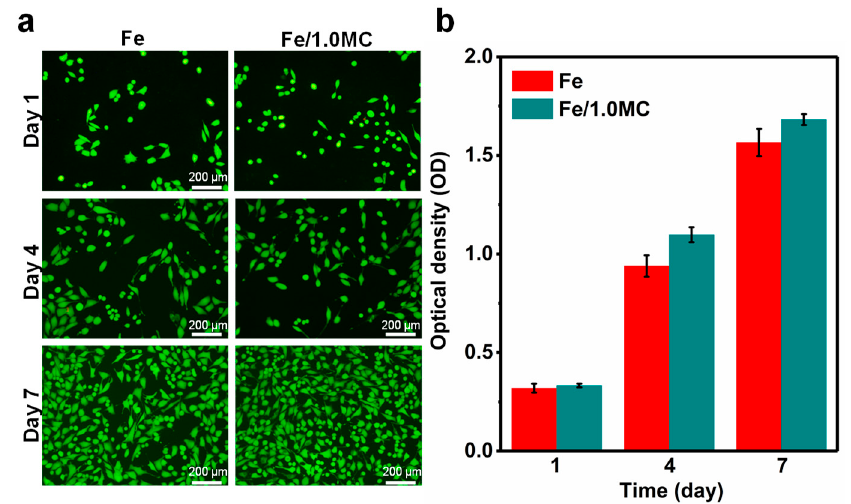
Figure 9. ( a ) Fluorescent microscopy images of stained cells; ( b ) CCK-8 assay results of Fe and Fe/1.0MC after 1, 4 and 7 d. n = 3.